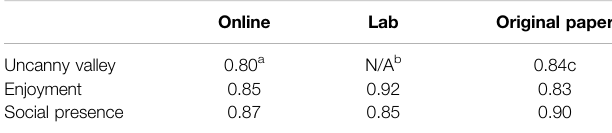
TABLE 3 | Cronbach ’ s α for subjective measures. We report similar reliability measures compared between online and lab studies, and in comparison to the original